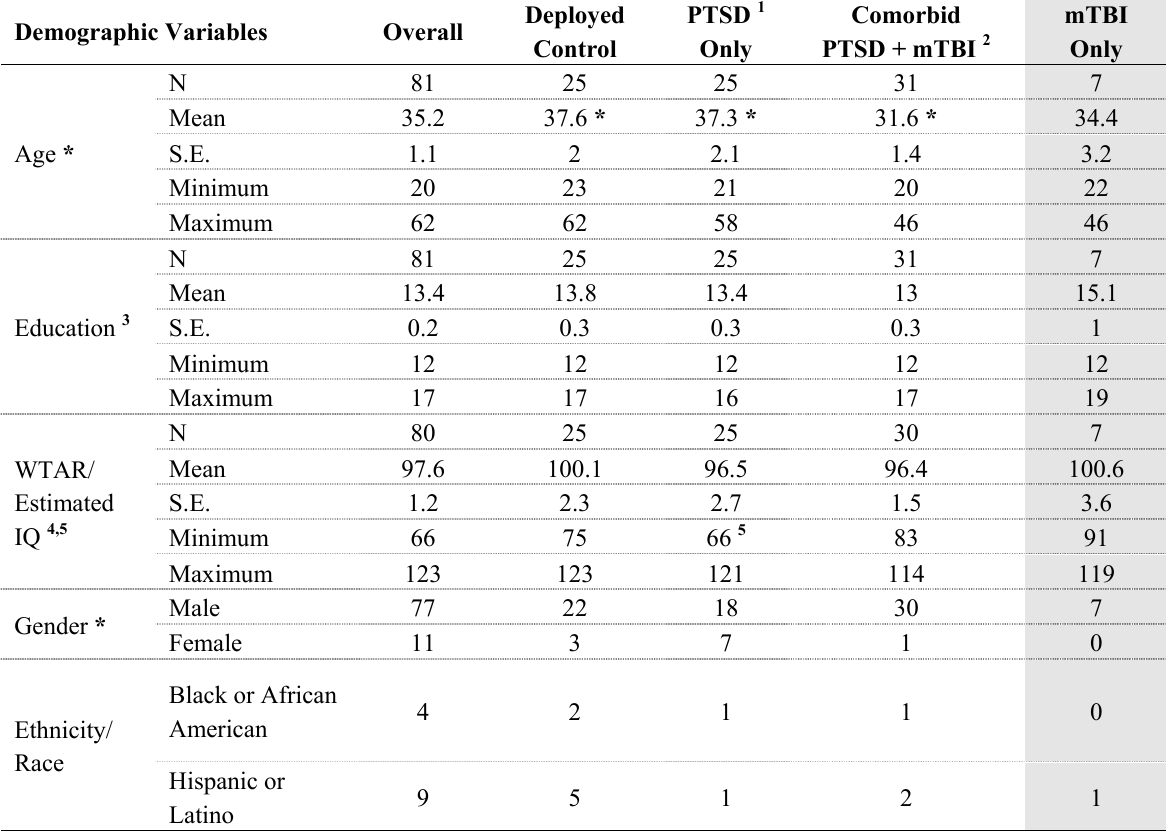
Table 1. Descriptive statistics for demographic and clinical characteristics. The Overall column represents the descriptive data for the three